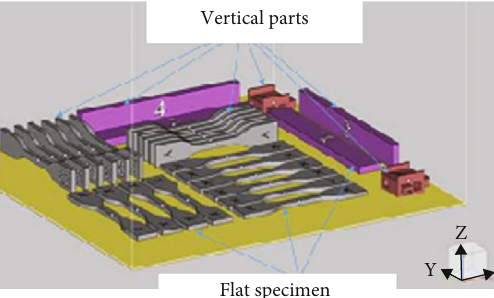
Figure 1: Orientation of the test coupons used to determine the best building chamber and removal chamber